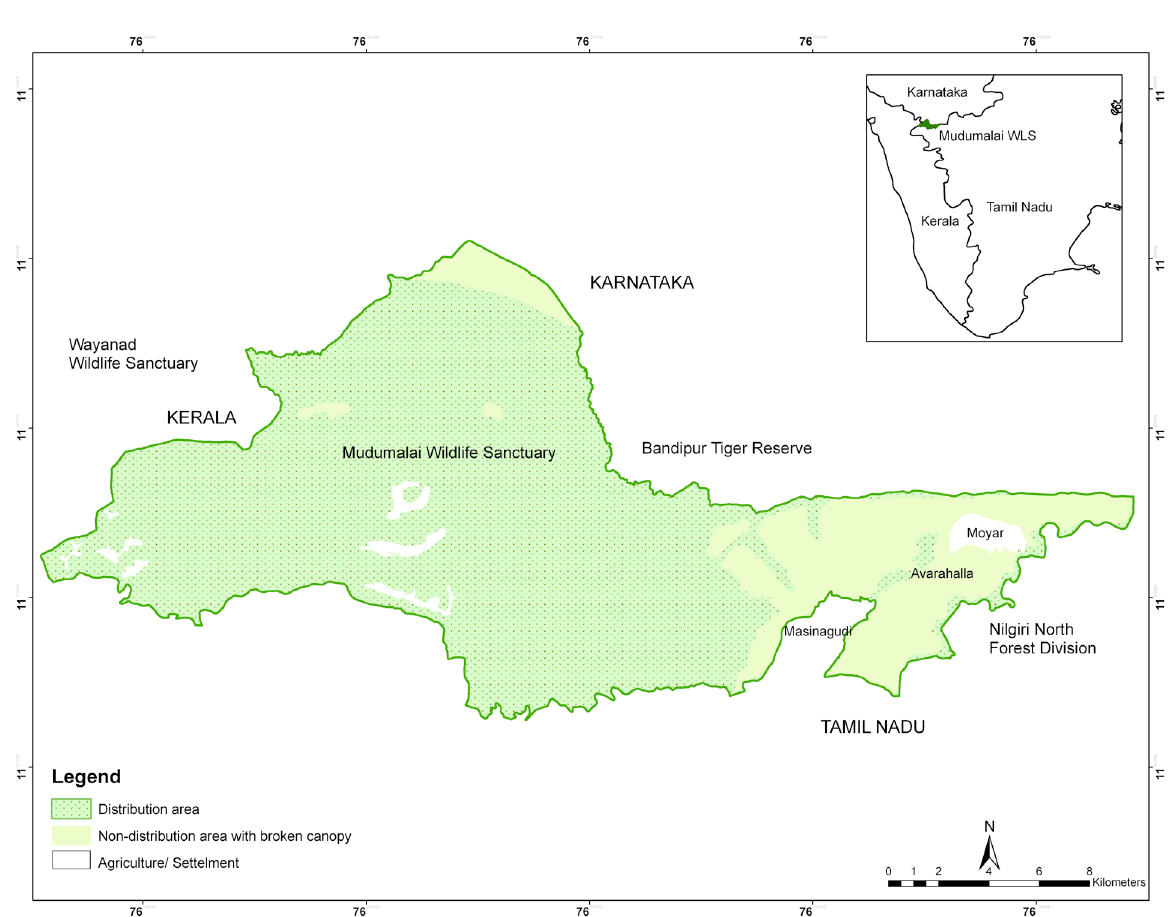
Figure 1. Map showing the distribution of Indian Giant Squirrel Rattufa indica in Mudumalai Wildlife Sanctuary,